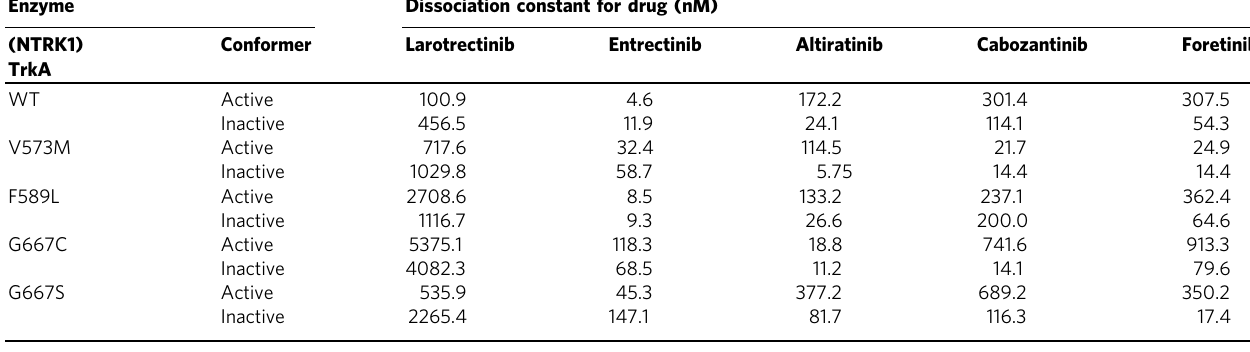
Table 1 Dissociation constants from molecular docking studies for wildtype and mutant NTRK1 kinases in their DFG-in or DFG- out conformers, as